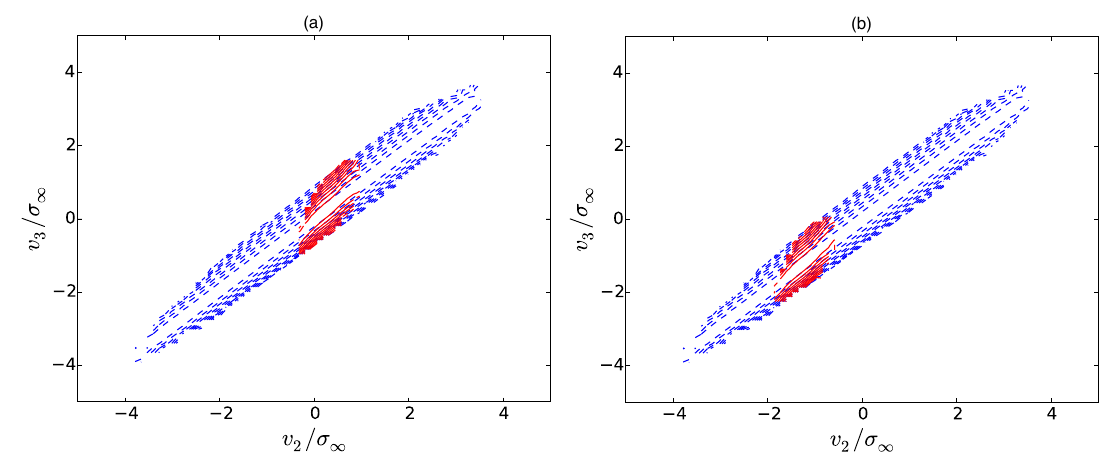
Figure 23. ( a ) examination of the Markov property (28) from DNS of the intermediate case for ∆ r = 0.2 λ and v 1 = 0 via a logarithmic contour plot; ( b ) same as in ( a ), but for v 1 = σ ∞ . The Markov property is violated.